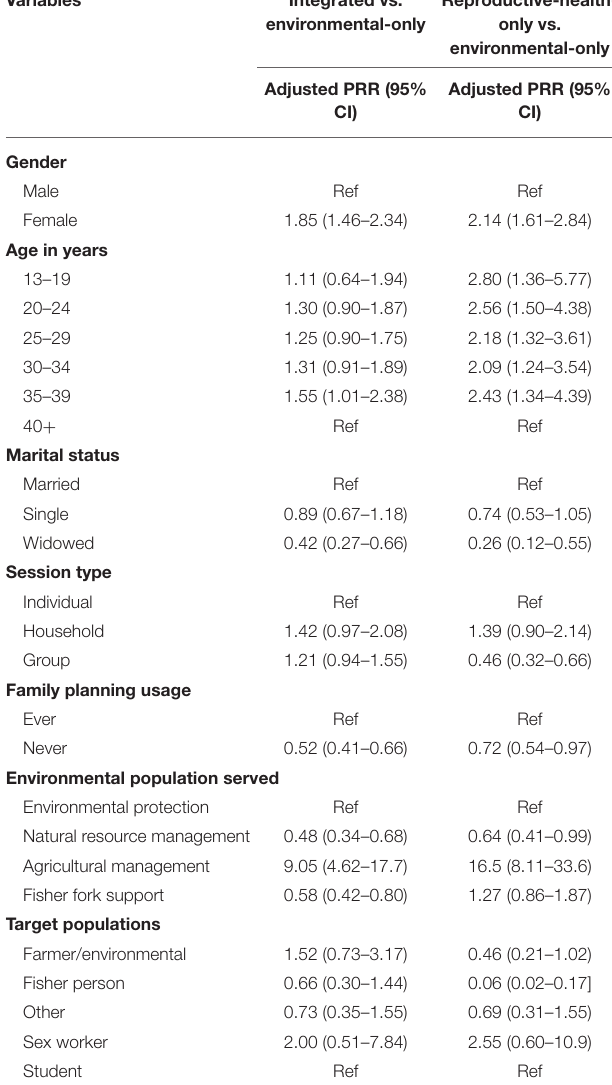
TABLE 6 | Results of multivariable multinomial logistic regression * : factors associated with integrated messaging, N = 10,156. Message Variables Integrated vs. Reproductive-health- environmental-only only